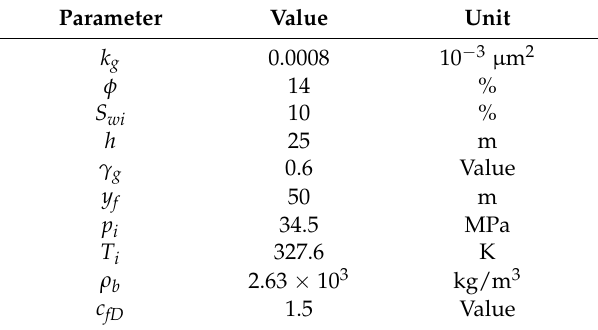
Table 1. Data used in